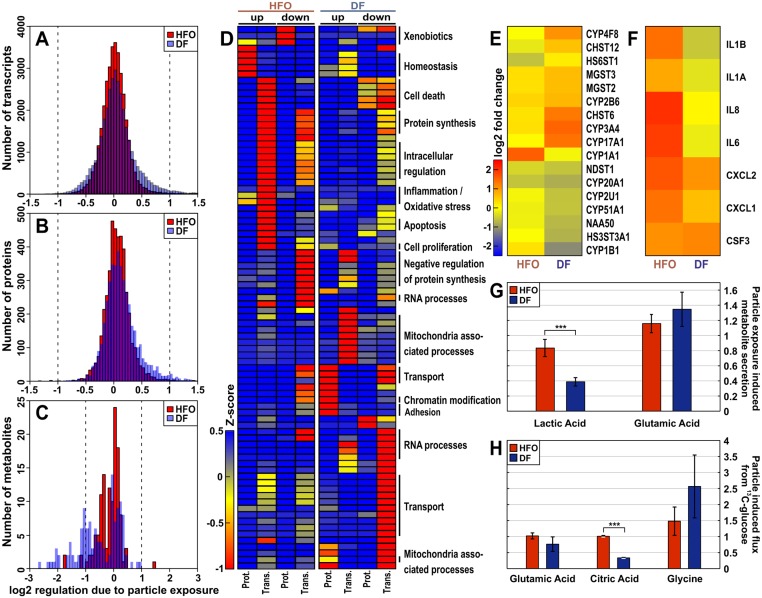
Effects of shipping particles on lung cells.The net effects from the particles were referenced against the gaseous phase of the emissions. (A) Number of the regulated components in the transcriptome shows more genes regulated by the DF than the HFO particles (in BEAS-2B cells). Similar results were observed for the proteome (B) and metabolome (C) (in A549 cells). (D) Meta-analyses for the transcriptome and proteome using the combined Gene Ontology (GO) term analysis of the 10% most regulated transcripts and proteins. Individual GO terms are listed in S2 Table; the hierarchical pathways are indicated on the right. (E) Gene regulation of Wiki-pathway bioactivation; (F) gene regulation of Wiki-pathway inflammation; g, secreted metabolites; and h, metabolic flux measurements using 13C-labelled glucose. For all experiments, n = 3.